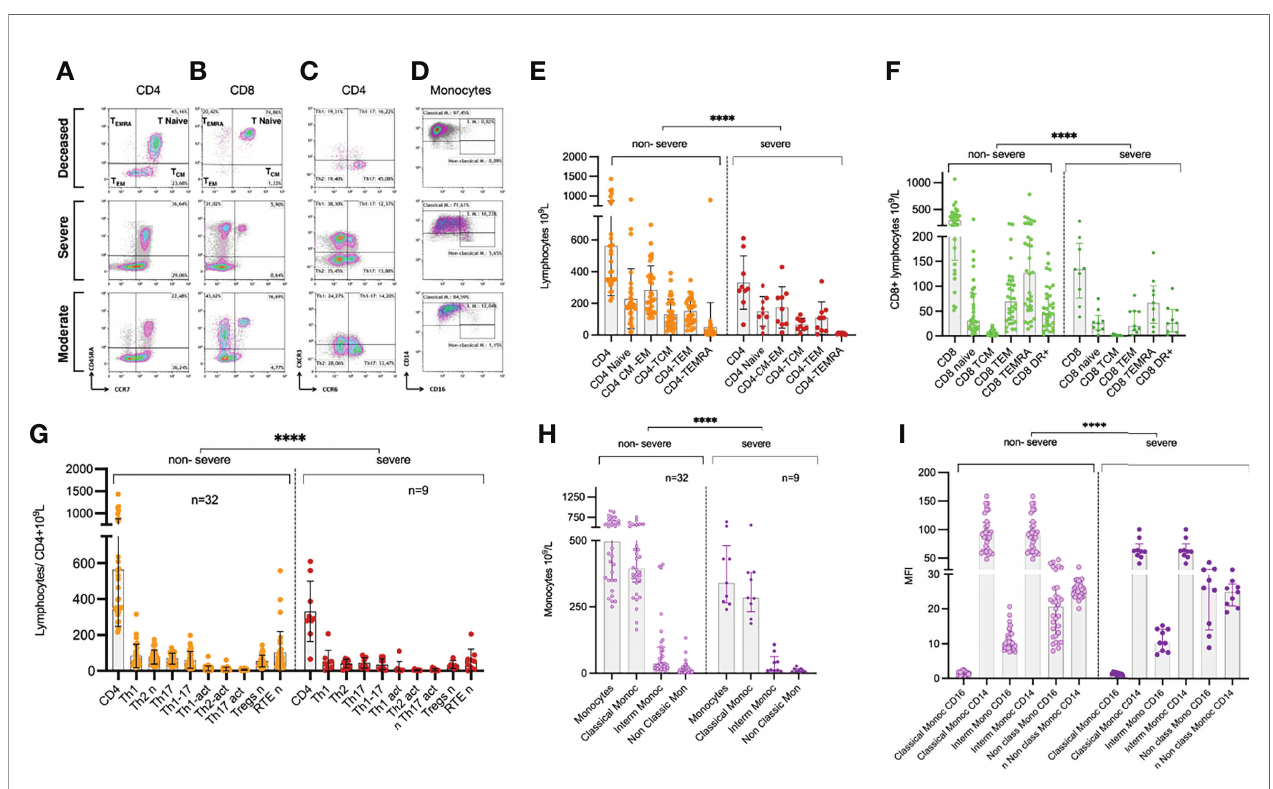
FIGURE 8 | Representative fl ow cytometry plots from the Vall d ’ Hebron University Hospital sub-cohort. (A) CD4 and (B) CD8 T lymphocyte subpopulations distributed by phenotypes based on CD45RA and CCR7. (C) CD4 T lymphocyte Th-polarisation by CXCR3 and CCR6 expression. (D) Monocyte subpopulations (classical, intermediate monocytes [IM] and non-classical monocytes) in a comparison of patients belonging to the deceased, severe, and moderate patient categories. (E) Distribution of CD4 naïve and memory subsets among non-severe and severe patients. (F) Distribution of CD8 naïve and memory subsets among non-severe and severe patients; (G) Distribution of CD4 Th polarized subsets among non-severe and severe patients; (H) Distribution of monocytes subsets among non-severe and severe patients; (I) Mean Fluorescent Intensity (MFI) of CD14 and CD16 in the different monocyte subsets among non-severe and severe patients. Non severe patients n=32 and severe patients n=9, for all plots; ****p < 0.0001 by non-parametric FDR corrected Kruskal-Wallis